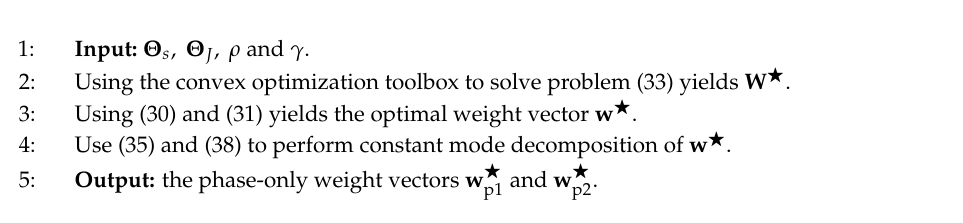
Algorithm 2: Proposed CMD Algorithm.